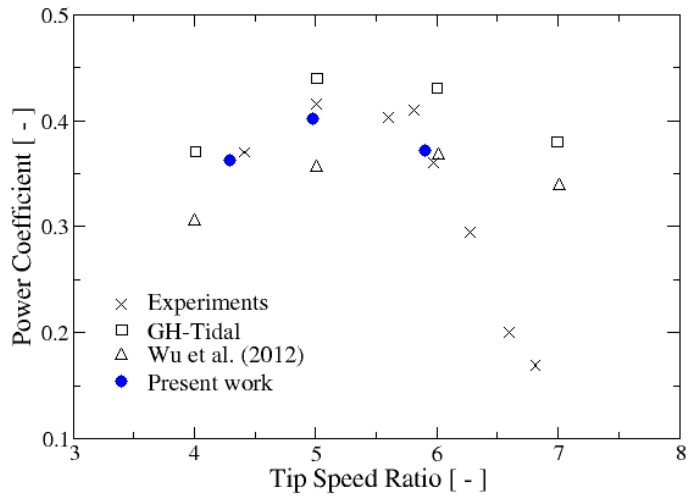
Figure 16. The comparison of the experimental measurements and CFD computations performed in this work on the turbine of Bahaj et al. (2007) [34].